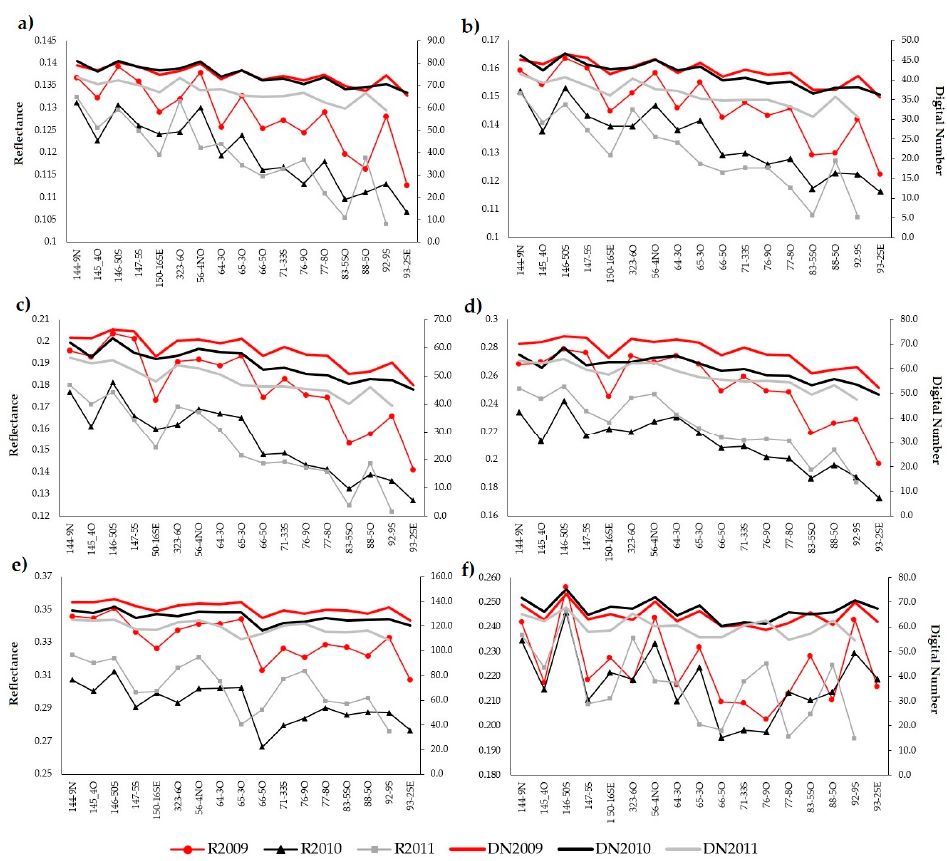
Figure 3. Spectral signature average expressed as reflectance and the digital number for each quadrant (( a ) band1, ( b ) band2, ( c ) band3; ( d ) band4, ( e ) band5, ( f ) band7). Forty-two models for CGC and grass height were obtained. They corresponded to three years, two dependent variables, three elements of TC with the original bands, radiometrically-corrected bands and three transformations of dependent with independent variables. Six of the models were selected, one for each variable per year. The selected models met the Gauss–Markov assumptions, and had the lowest statistical deviance information criterion, Akaike information criterion, Bayesian information criterion, (DIC, AIC, BIC) and the Root Mean Square Error (RMSE). In all the cases, the selected models only used images from bands into original digital values or in combination with an